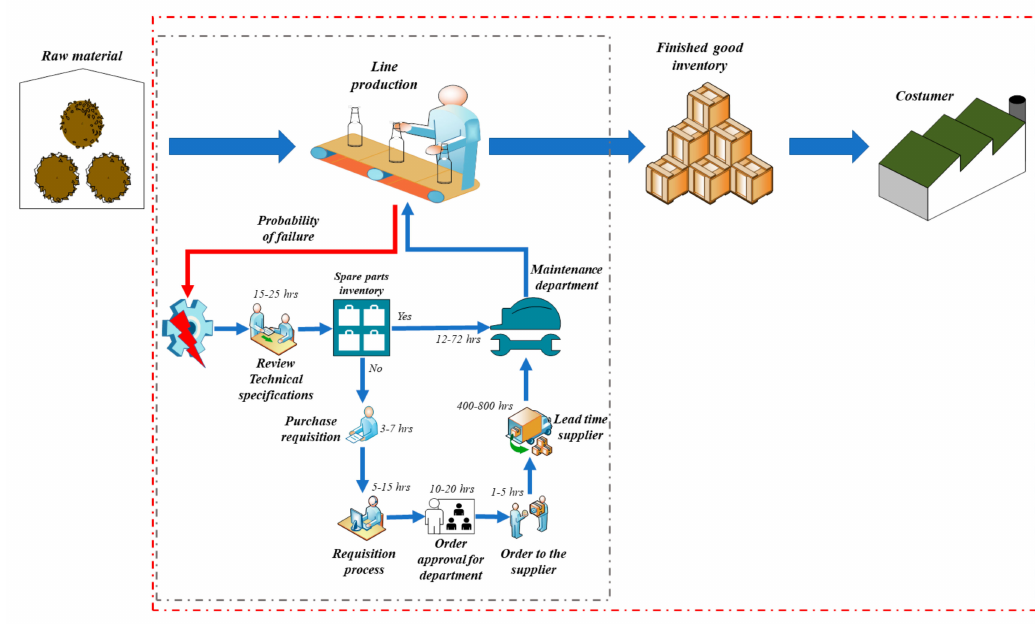
Figure 1. Model analyzed in a BPE (Bottle Processing Enterprise)